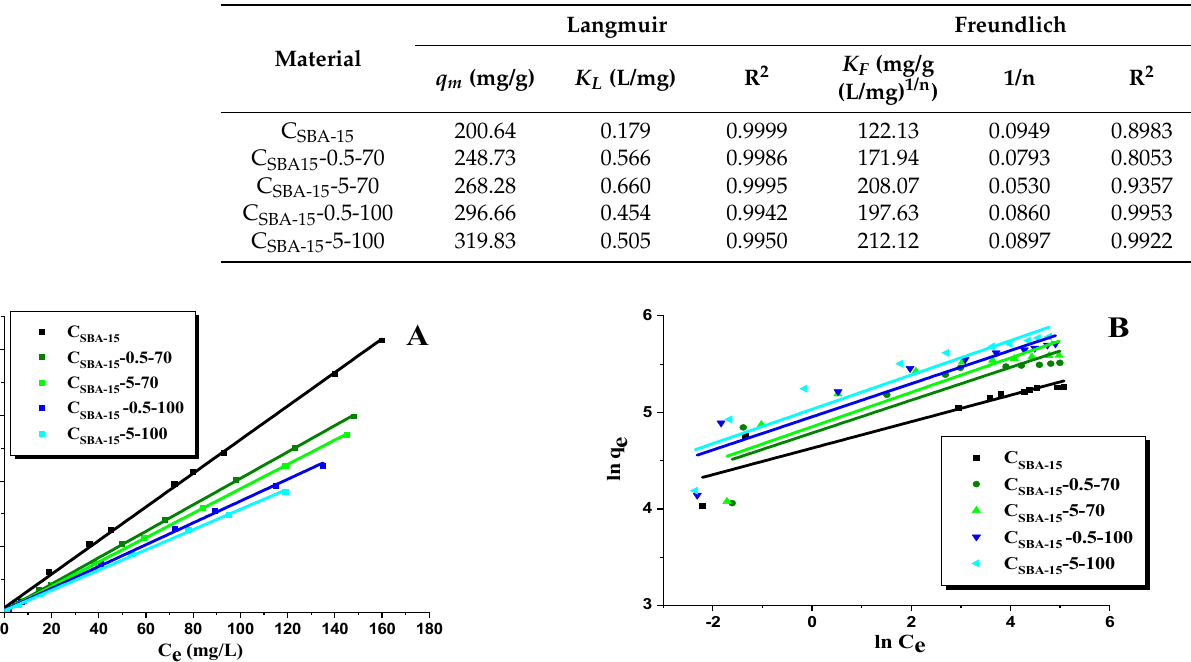
Table 6. The parameters of non-linear Langmuir and Freundlich models for rhodamine B adsorption onto carbon materials. Figure 7. Adsorption of rhodamine B onto adsorbents obtained.